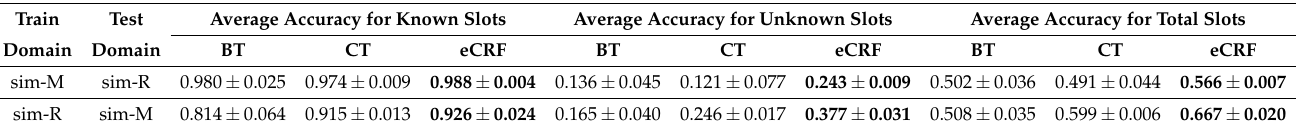
Table 2. Results for the cross-domain tasks: average exact matching accuracies for values from known slots, unknown slots and total slots on test domain for three models. Bold numbers mean the best results among three compared models. Train Test Average Accuracy for Known Slots Average Accuracy for Unknown Slots Average Accuracy for Total Slots